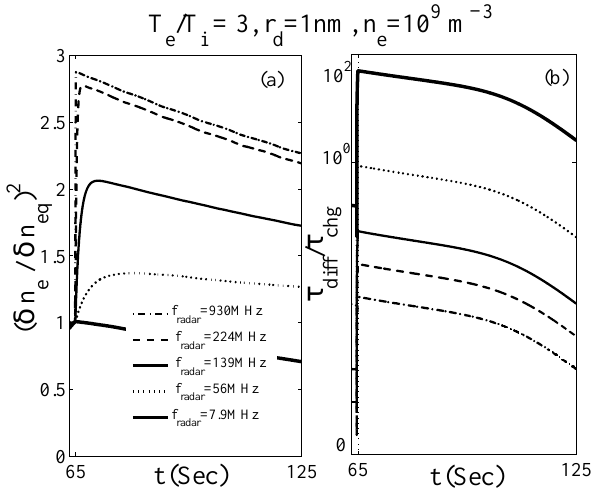
Fig. 6. The wave number spectrum for electron density fluctuation evolution, during and after radio wave heating. Fig. 5. (a) The time evolution of electron irregularities after turn-off of the radio wave heating with varying irregularity scale size utilizing the computational model. The heating is turned off at 65s. (b) Ratio of diffusion timescale to charging timescale.